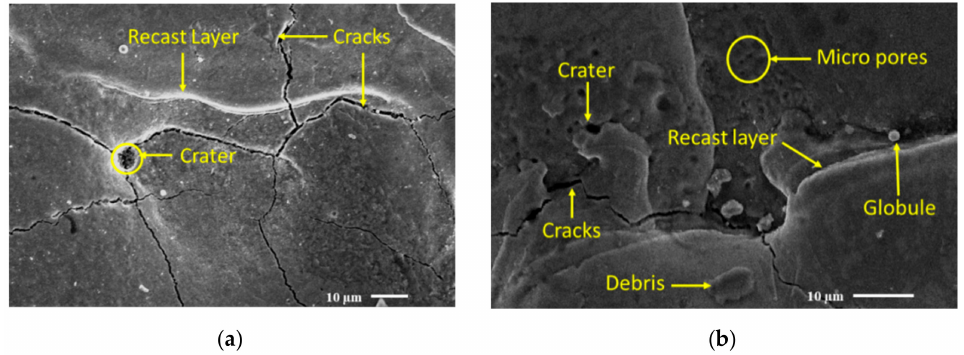
Figure 10. Variation of surface morphology with Ton (I p , V g , T on , T off , P) ( a ) (7, 60, 250, 30, 16); ( b ) (7, 60, 450, 30, 16); units as per Table 2.